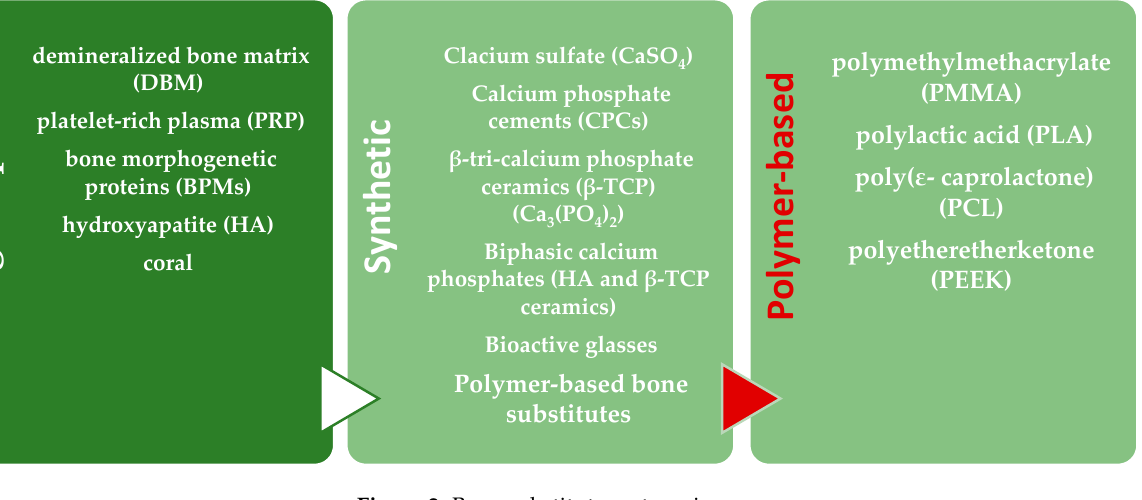
Figure 2. Bone substitutes categories.